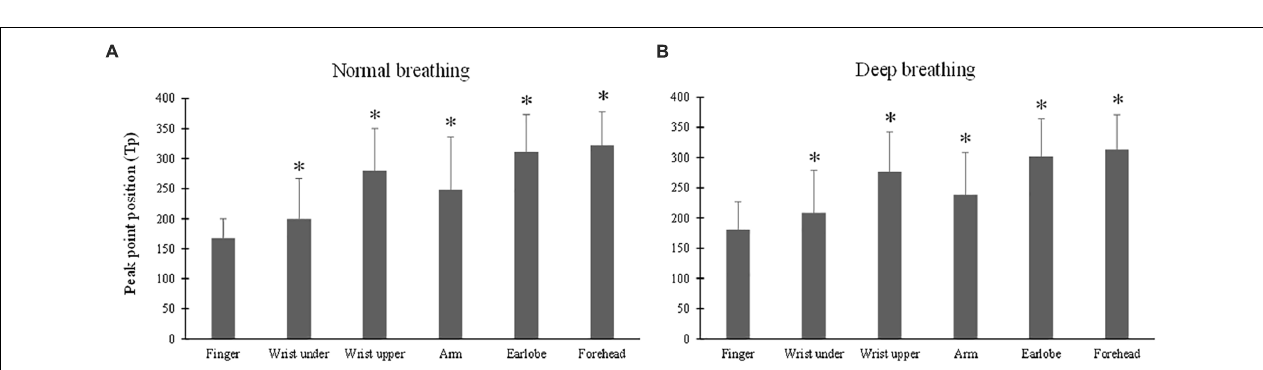
FIGURE 5 | Photoplethysmography pulse peak point position (Tp) measured from different sites under normal (A) and deep (B) breathing patterns. ∗ Marks the significant difference in comparison with that from the finger ( p < 0.05).